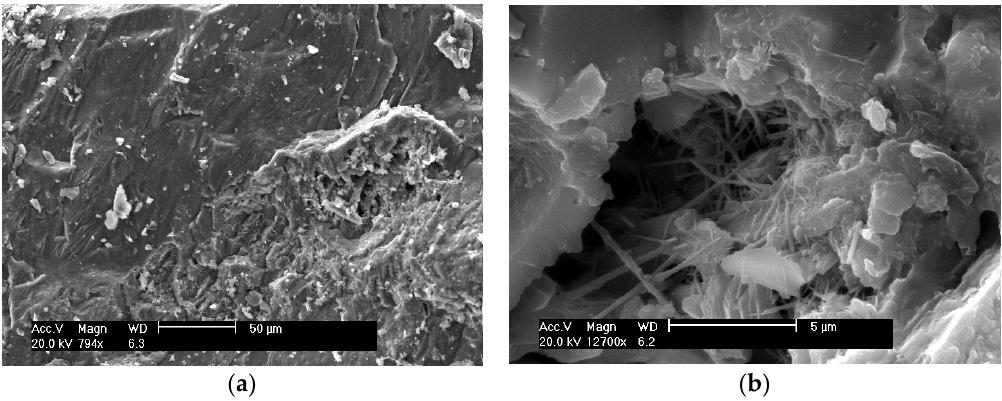
Figure 7. SEM of FRHA concrete: ( a ) with magnification of ×794; ( b ) with magnification of ×12700.